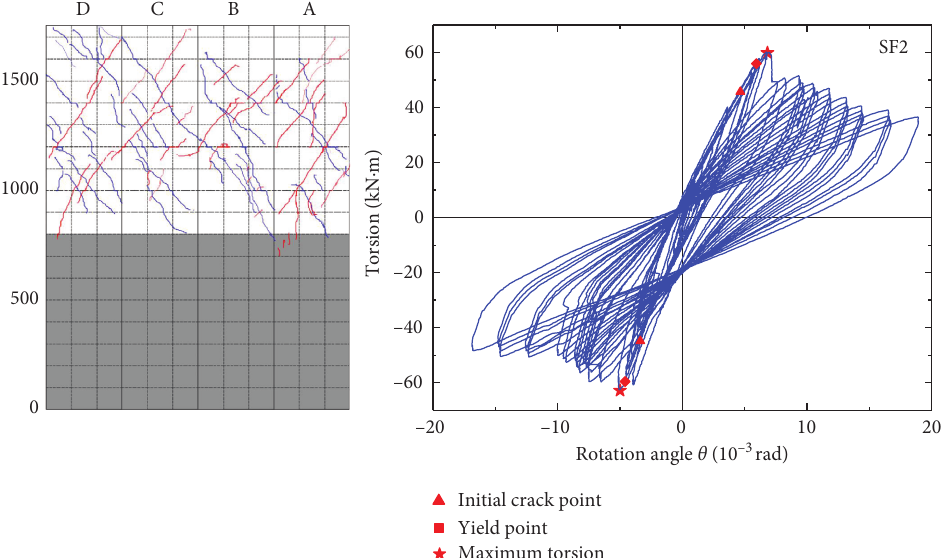
Figure 11: Damage and hysteresis curves of specimen